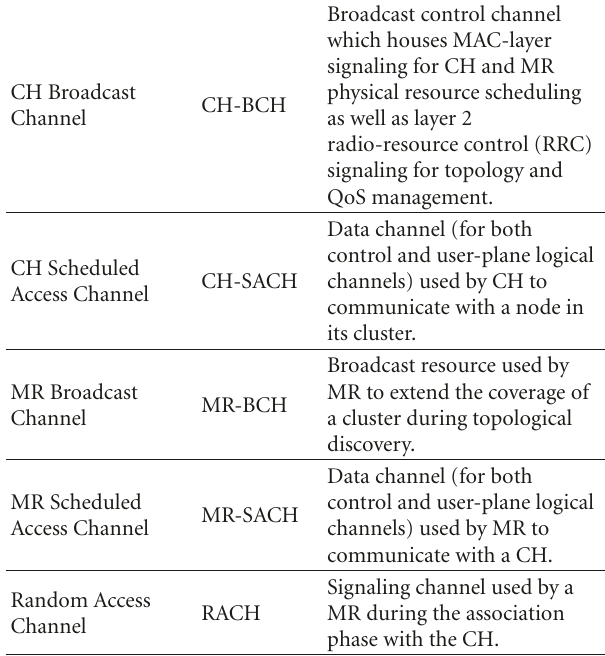
Table 4: Transport and physical channels. Each of the transport channels is mapped to a corresponding physical channel of the same name.